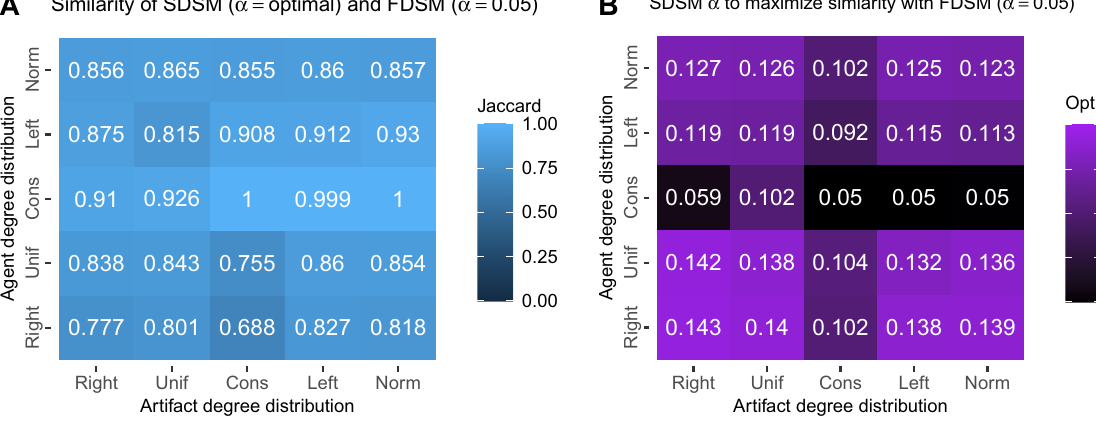
Figure 4. ( A ) Given agent and artifact degree distributions, there exists a statistical significance level α that maximizes the similarity between an SDSM backbone extracted at this level and an FDSM backbone extracted at α = 0.05 , and ( B ) when used yields an SDSM backbone that is very similar to the corresponding FDSM